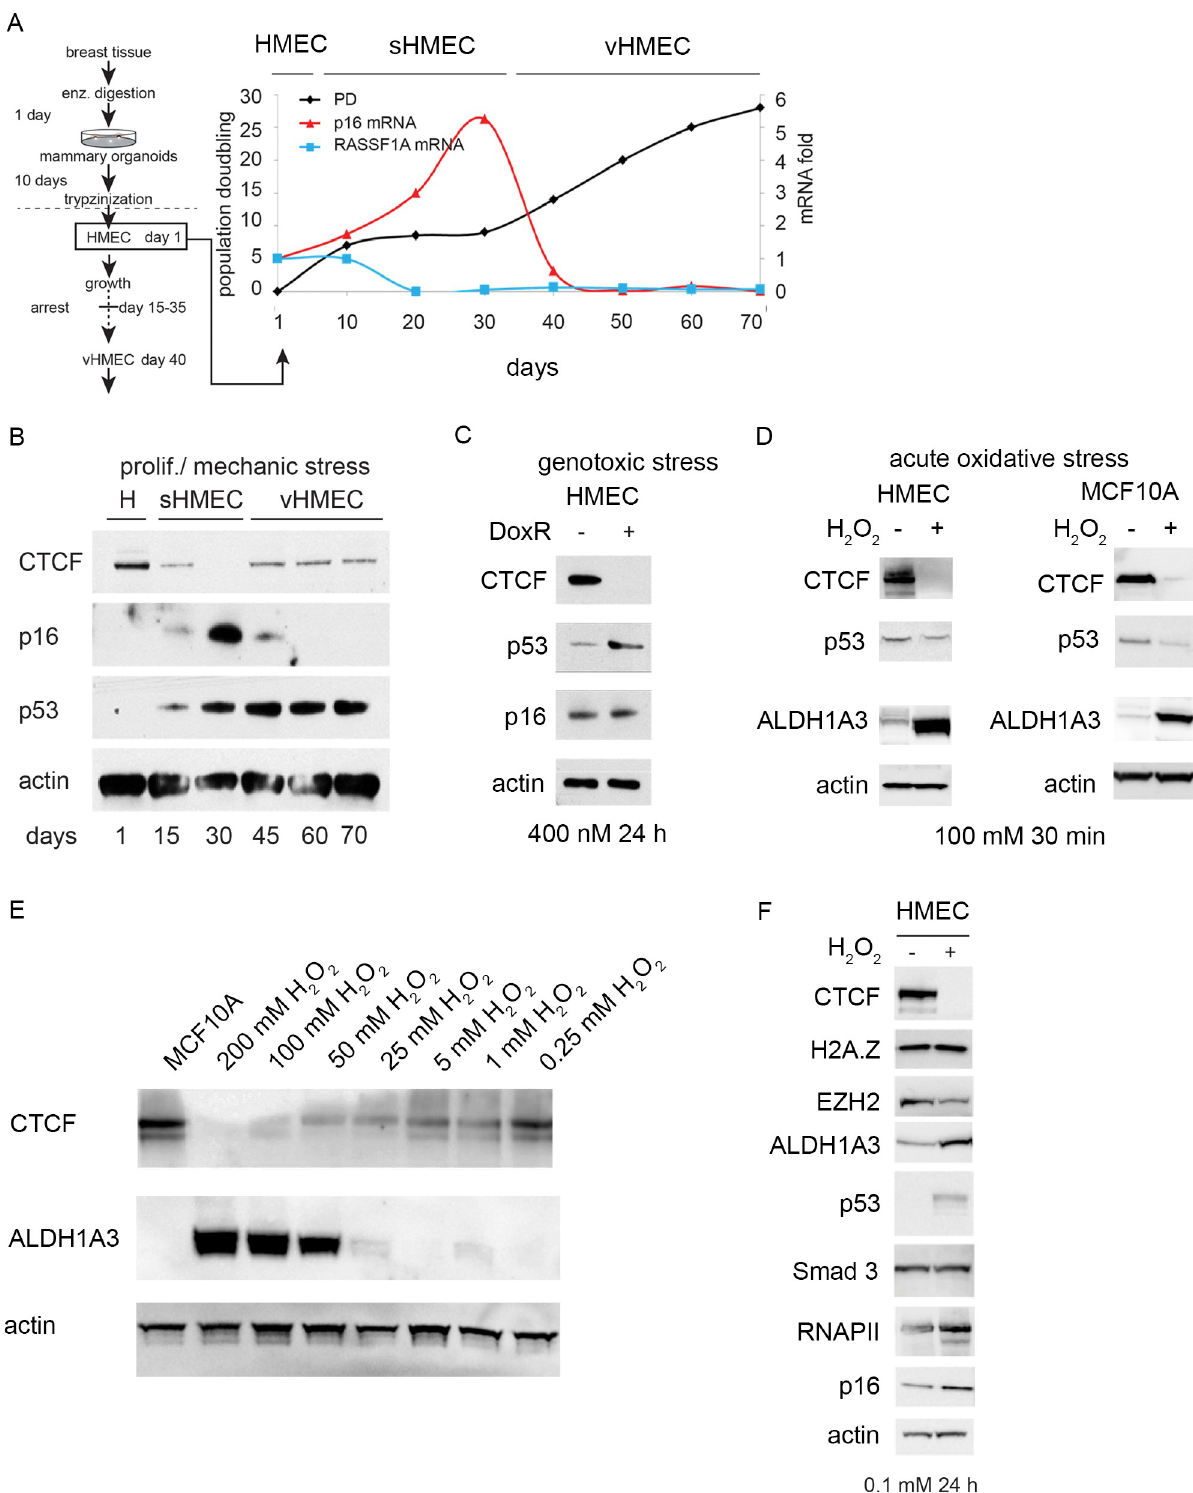
Fig 1. CTCF protein levels are selectively downregulated in normal epithelial cells upon stress. (A) HMEC isolation and cell culture diagram; population doublings and mRNA levels of tumor suppressors p16 and RASSF1A which are typically silenced in the classic HMEC/vHMEC primary culture model. Days in culture are indicated at the bottom. mRNA was measured by RT-qPCR and expressed as fold-change relative to day 1. (B) Protein extracts were prepared from patient-matched HMECs and vHMECs and analyzed by Western blot with the indicated antibodies.